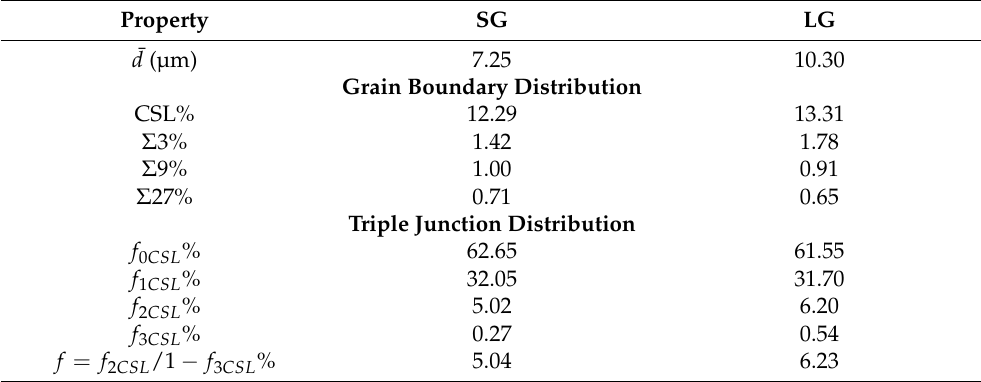
Table 3. Summary of grain boundary characteristics for small grain (SG) and large grain (LG) samples of